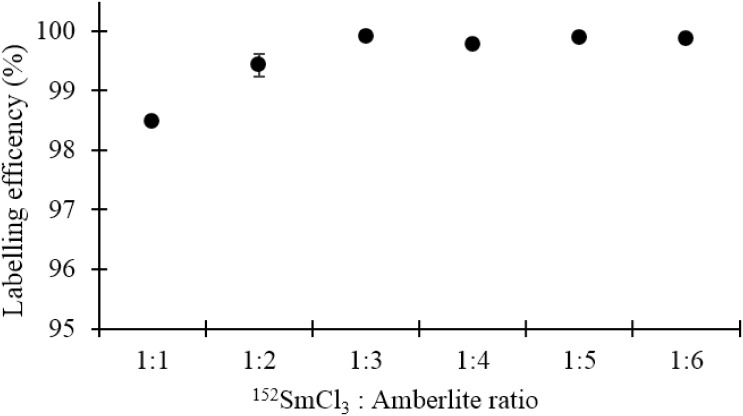
Labelling efficiency (%) of various formulations of 153Sm-Amberlite microparticles.